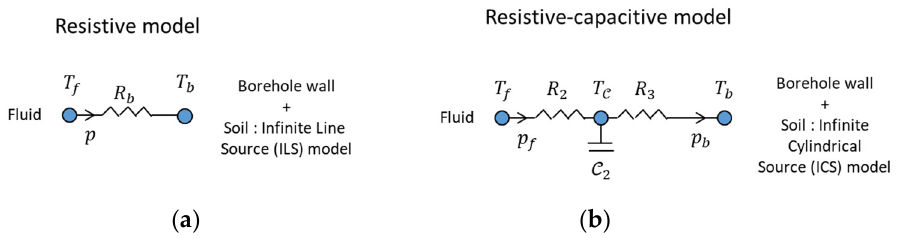
Figure 2. ( a ) Purely resistive classical model vs. ( b ) developed resistive-capacitive